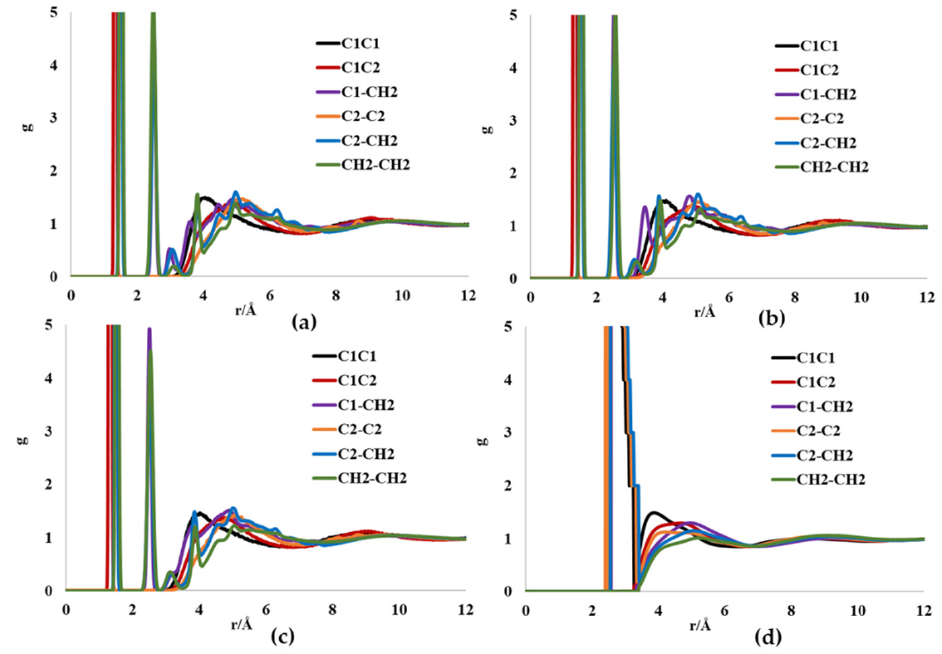
Figure 2. Radial distribution functions from the MD simulations with ( a ) CHARMM, ( b ) OPLS, and ( c ) GROMOS force fields, and partial distribution functions from the X-RISM-KH simulations with ( d ) TraPPE force field parameters.